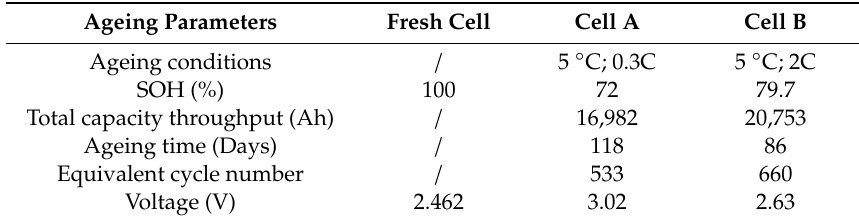
Table 2. State of health (SOH), total capacity throughput, equivalent cycle number, time required for ageing and voltage of the cells before